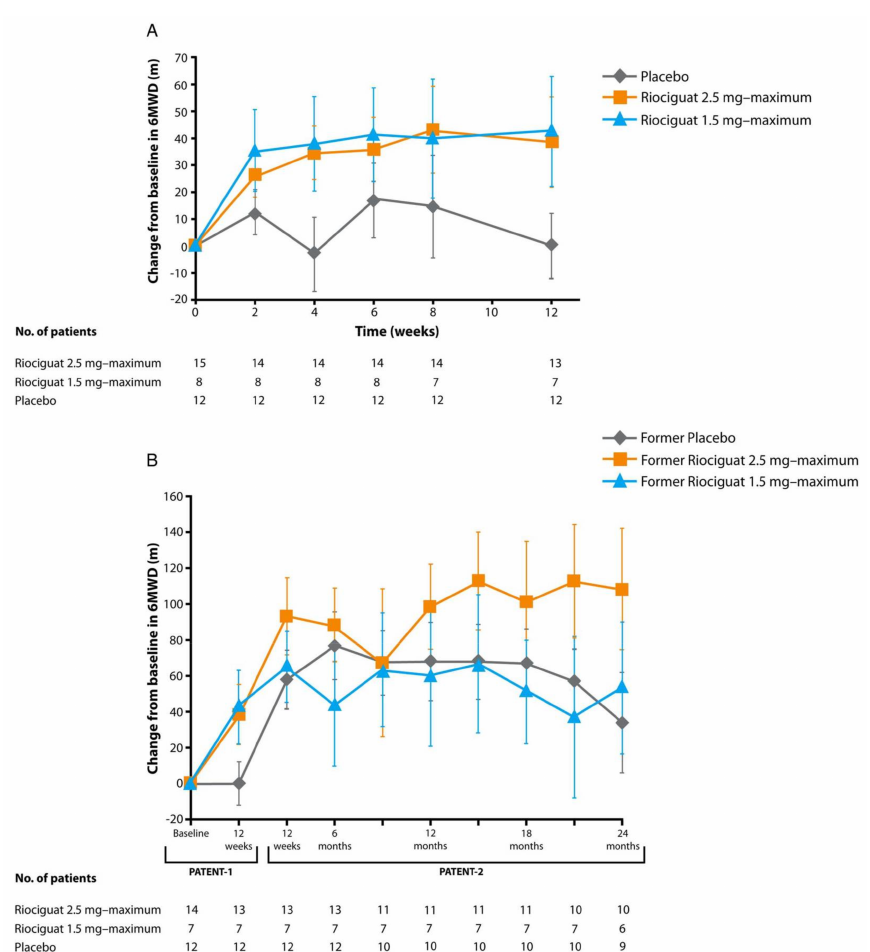
Figure 14. Change from baseline in 6-min walking distance (6MWD) in the subgroup of patients with pulmonary arterial hypertension associated with congenital heart disease in Pulmonary Arterial hyperTENsion sGC-stimulator Trial-1 (PATENT-1; ( A ) and PATENT-2 ( B )). Data are observed values (mean ± SEM)